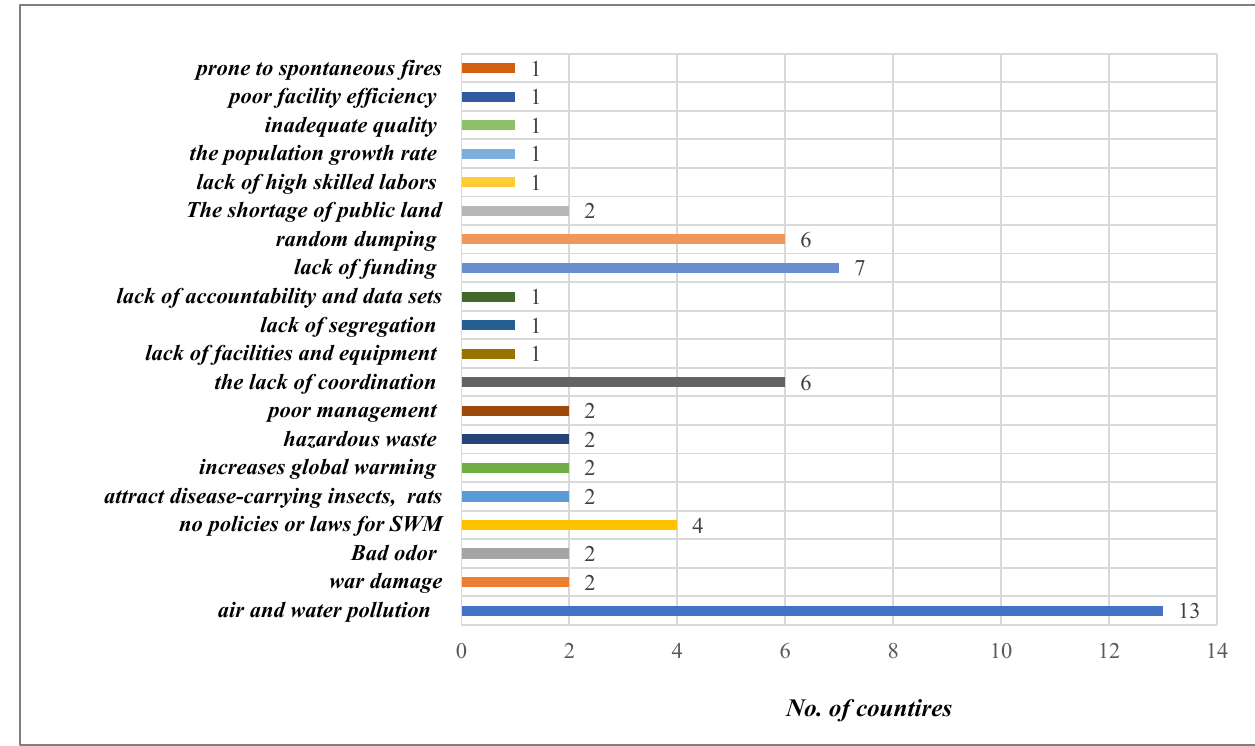
Figure 6. SWM ‐ related challenges faced by Arab countries.